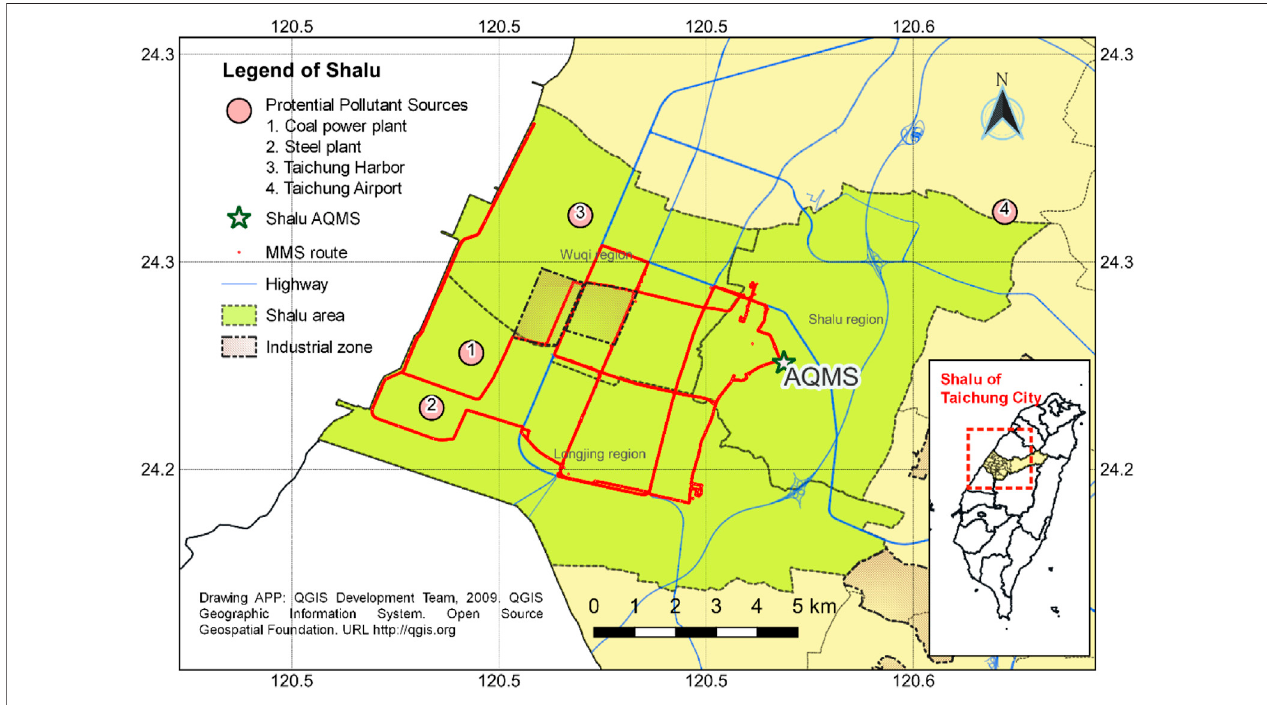
FIGURE 1 | Location of Taichung City and the study area,